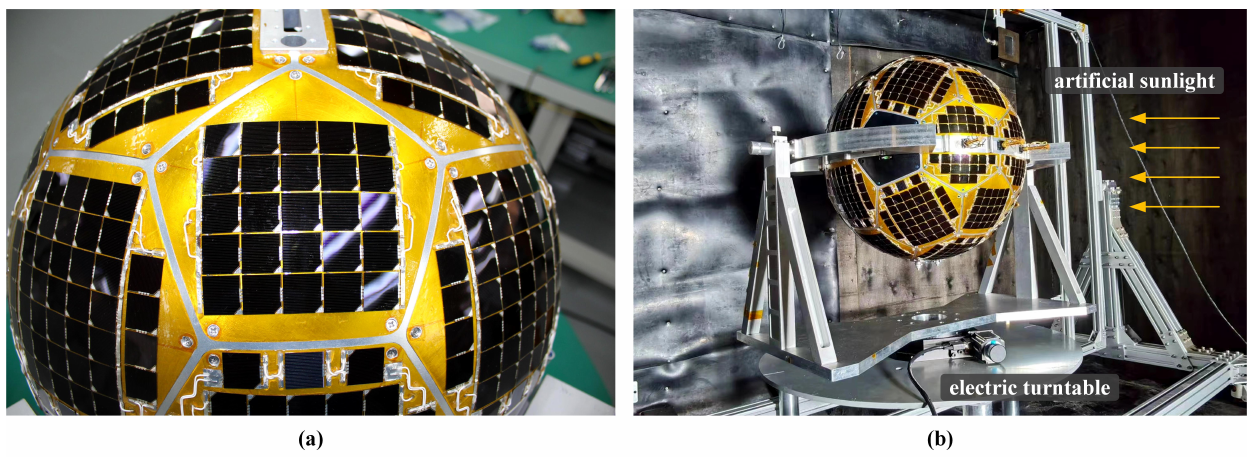
Figure 15. Q-SAT before launch. ( a ) Totally 991 solar cells are mounted on the spherical surface. ( b ) Q- SAT is undergoing the ground experiment to test the feasibility and performance of the proposed IPSS using artificial